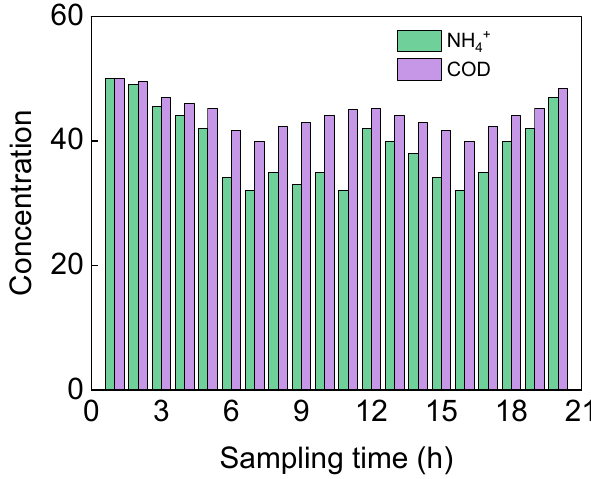
Figure 4. Changes of the concentrations of ammonium and COD in the column.